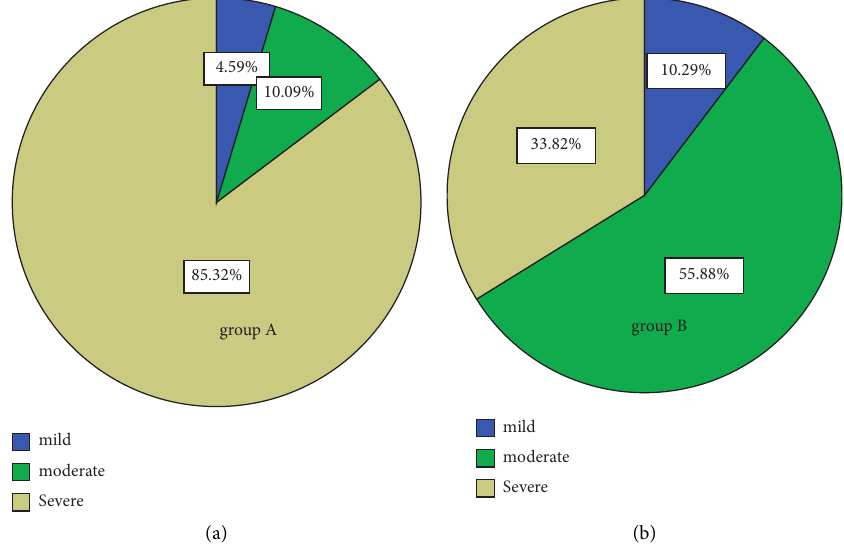
Figure 2: Proportion of mild-to-severe OSA in group A (patients co-occurring OSA and TBAD) and group B (patients co-occurring OSA and TB-AIMH). (a) The proportion of mild-to-severe OSA in patients with TBAD: 4.59% mild OSA, 10.09% moderate OSA, and 85.32% severe OSA. (b) The proportion of mild-to-severe OSA in patients with TB-AIMH: 10.29% mild OSA, 33.82% moderate OSA, and 55.88% severe OSA. Table 2: Comparison of demographic and biochemical characteristics in all the three groups.